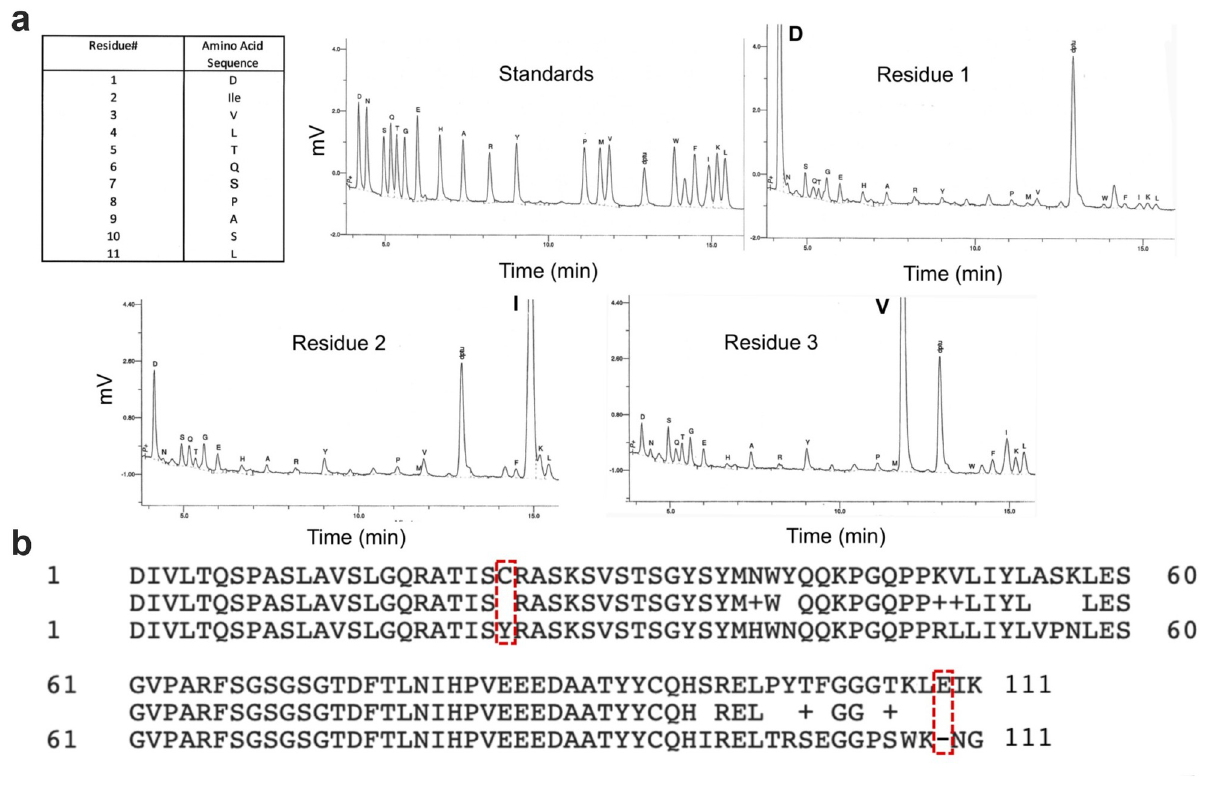
Fig 4. Identification of frameshift-corrected analog of Sp2/0 V L cDNA. (a) Results of Edman sequencing of H5C6 hybridoma-derived mAb— summary, standards, and first three residues are shown. (b) Comparison of amino acid sequences of full-length SP2 V L cDNA and aberrant Sp2/0 myeloma sequence. Both the frameshift mutation and the conserved cysteine (C23Y) mutation are corrected in the full-length gene product.